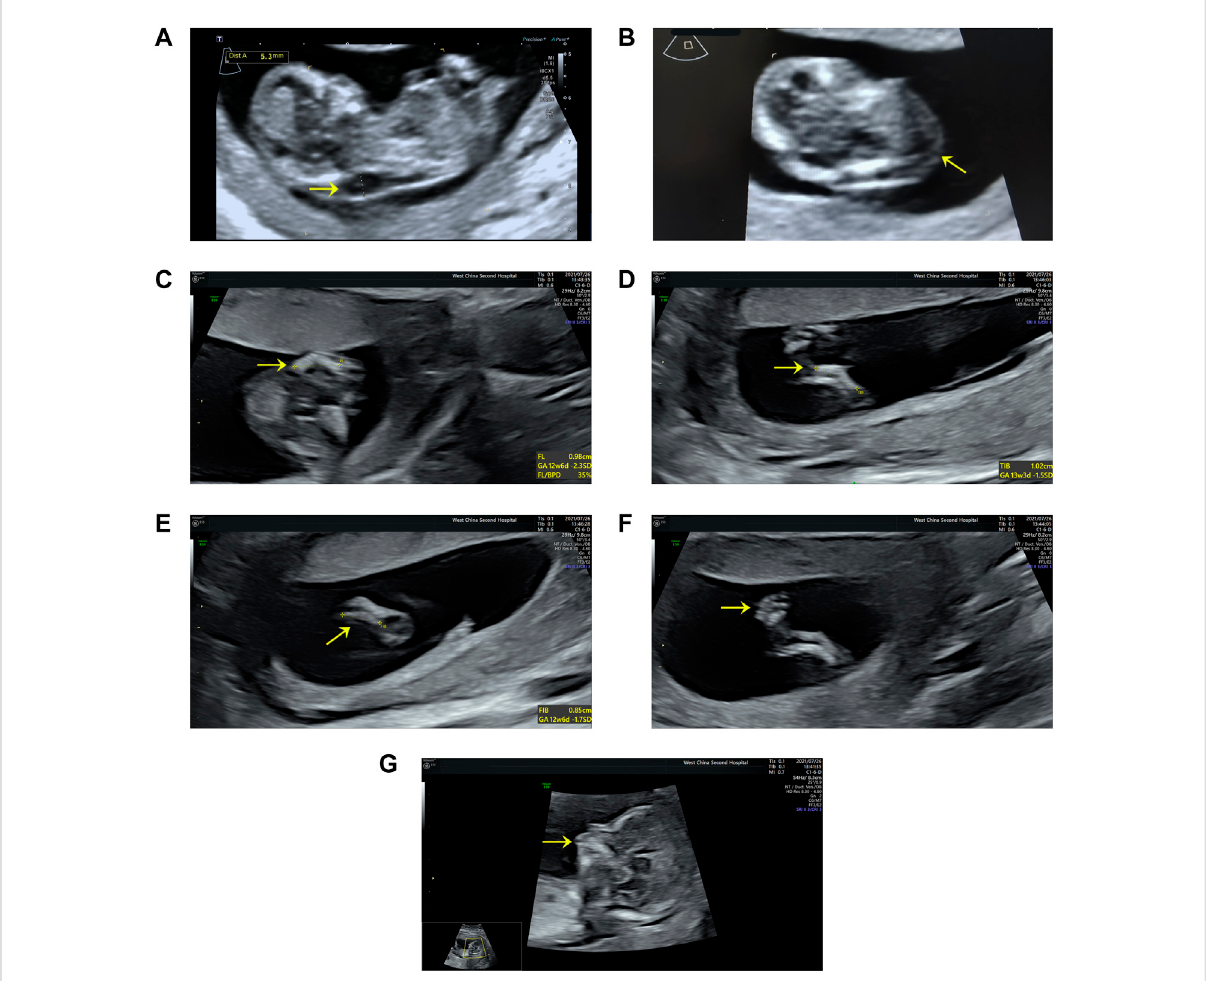
FIGURE 1 Ultrasound fi ndings: (A) Cystic hygromameasuring 18 × 6× 14 mm (CRL:60.9 mm)atthemid-sagittal plane. (B) Cystic hygroma inatransverse view. (C) Short andbowed femurs( < fi rst centile). (D) Sagittalanteriorangulatedtibiae( fi fthcentile). (E) Sagittalanteriorangulated fi bula( fi fth centile). (F) Unilateral equinovarus clubfoot. (G)